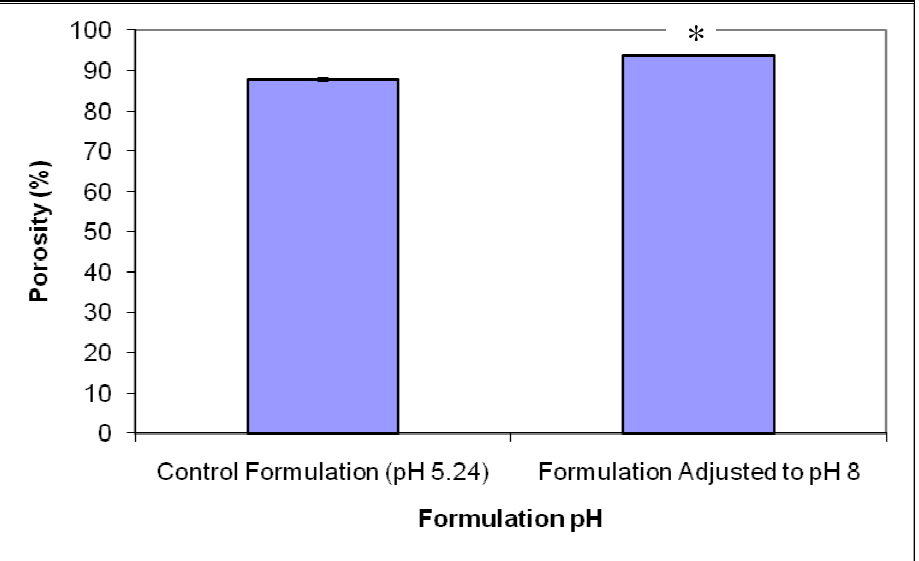
Figure 1. The effect of formulation pH on the porosity of the freeze-dried tablets (mean ± S.E., n = 3) (* statistically